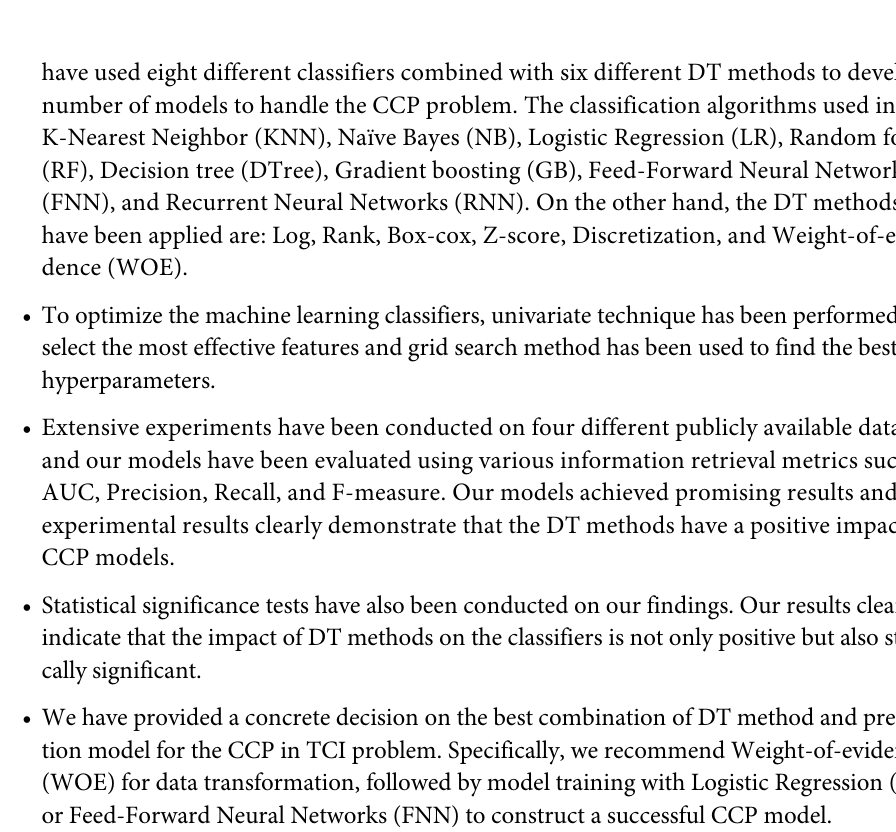
have used eight different classifiers combined with six different DT methods to develop a